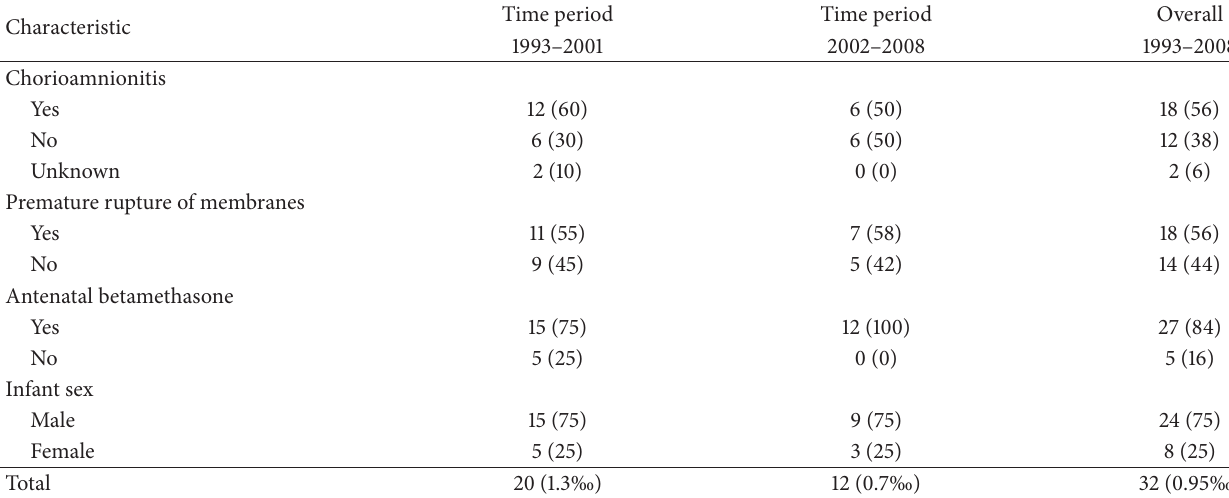
Table 2: Characteristics and management of the cystic periventricular leukomalacia (cPVL) group ( 𝑛 = 32 ) by study period.